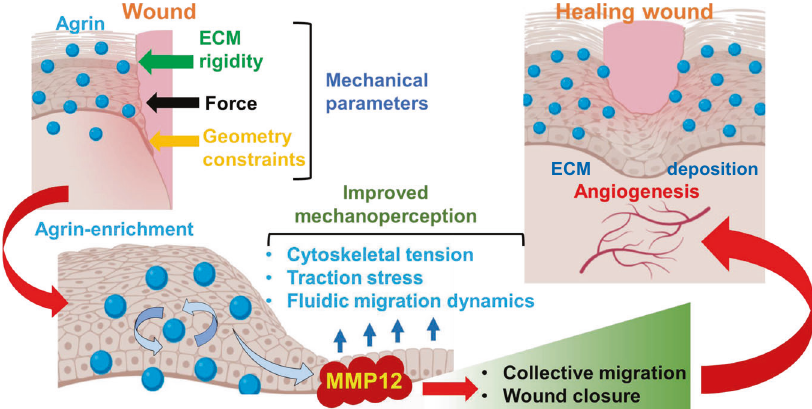
Fig. 8 A working model explaining that wound injury triggered Agrin microenvironment favors a productive healing program. Brie fl y, Agrin sensitizes the wounded cells towards ECM rigidity, force recognition, and geometric constraints accounting for improved traction stress, elasticity, and cytoskeletal tension to promote enhanced fl uid-like dynamic collective migration (blue arrows) over the wounded sites. Further, Agrin activates MMP12 as its downstream effector to upgrade the mechanoperception of keratinocytes and actomyosin integrity during keratinocyte migration. The cumulative outcome of an Agrin-driven mechanically competent wound healing micro-environment yields higher collective migration and wound closure via facilitating re- epithelization, optimal ECM deposition, and